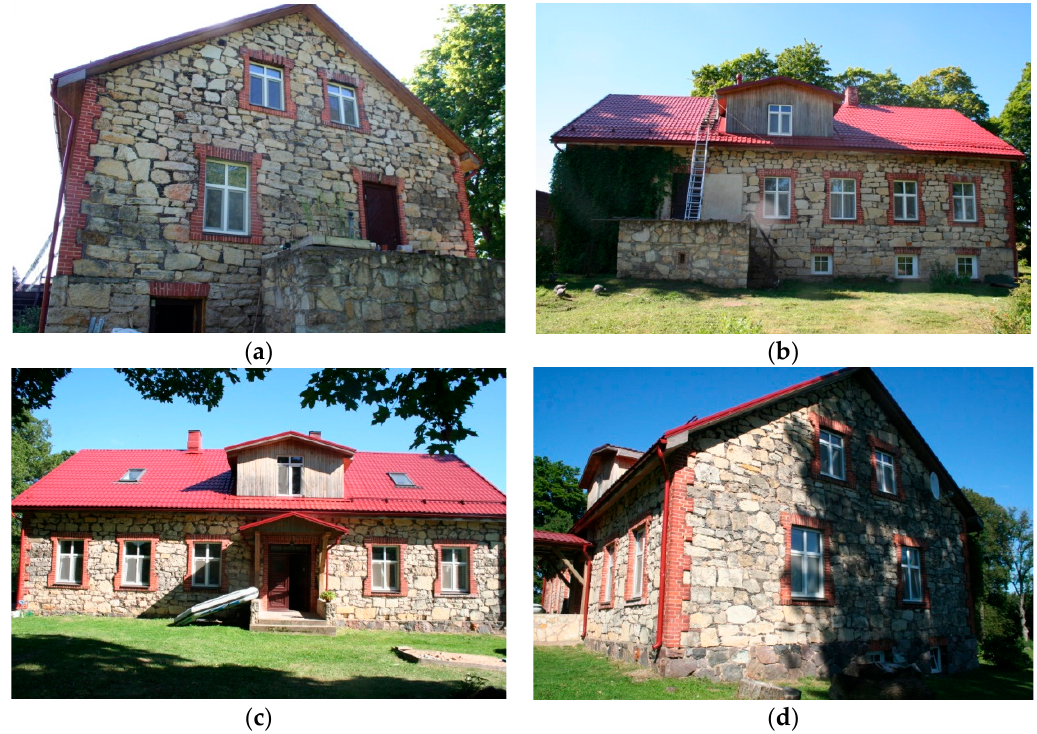
Figure 2. Facades of the case study building: ( a ) north ‐ east, ( b ) south ‐ east, ( c ) north ‐ west, ( d ) south ‐ west.